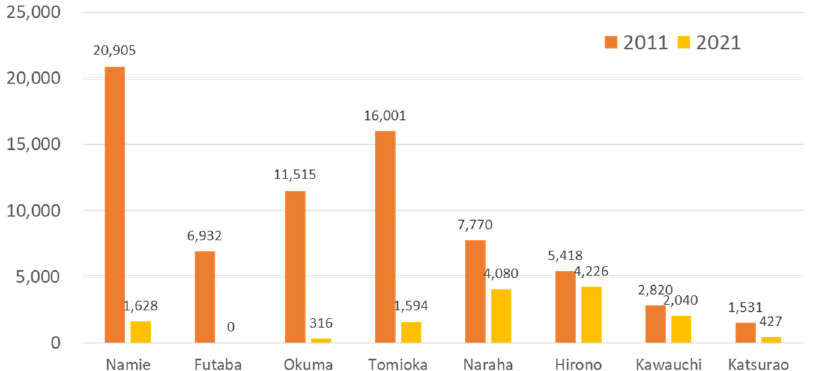
Figure 2. Population of municipalities in Futaba County before (2011) and 10 years after the Fukushima accident (2021).